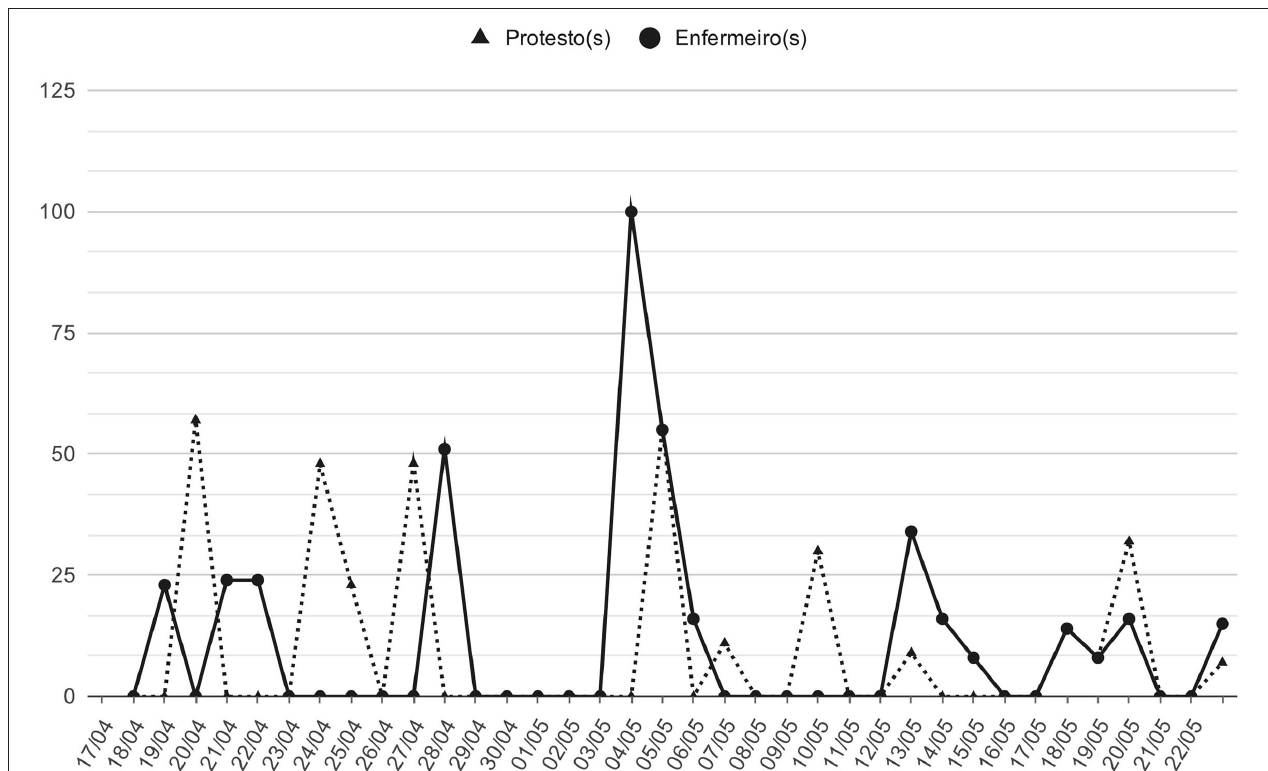
FIGURE 3 | Web Search for “World Health Organization,” “asymptomatics,” and “transmission” between 5/25/20 and 6/22/20. https://trends.google.com/trends/ explore?date=2020-05-15%202020-06-30&geo=BR&q=OMS,Assintom%C3%A1ticos,transmiss%C3%A3o.